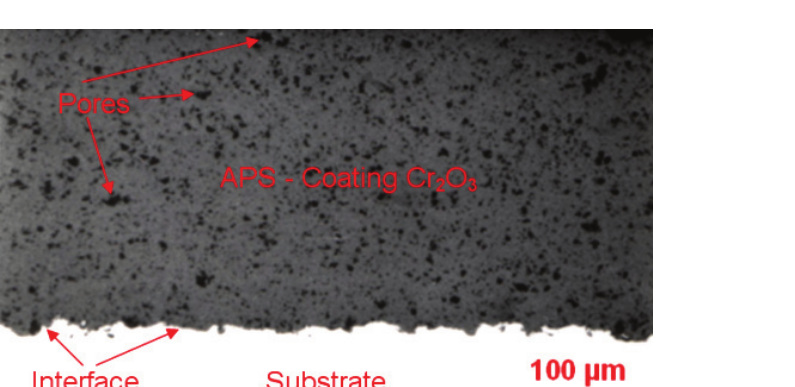
Figure 6 – Cr 2 O 3 coating microstructure deposited from a distance of 110mm Рис . 6 – Микроструктура покрытия Cr 2 O 3, нанесенного с расстояния 110